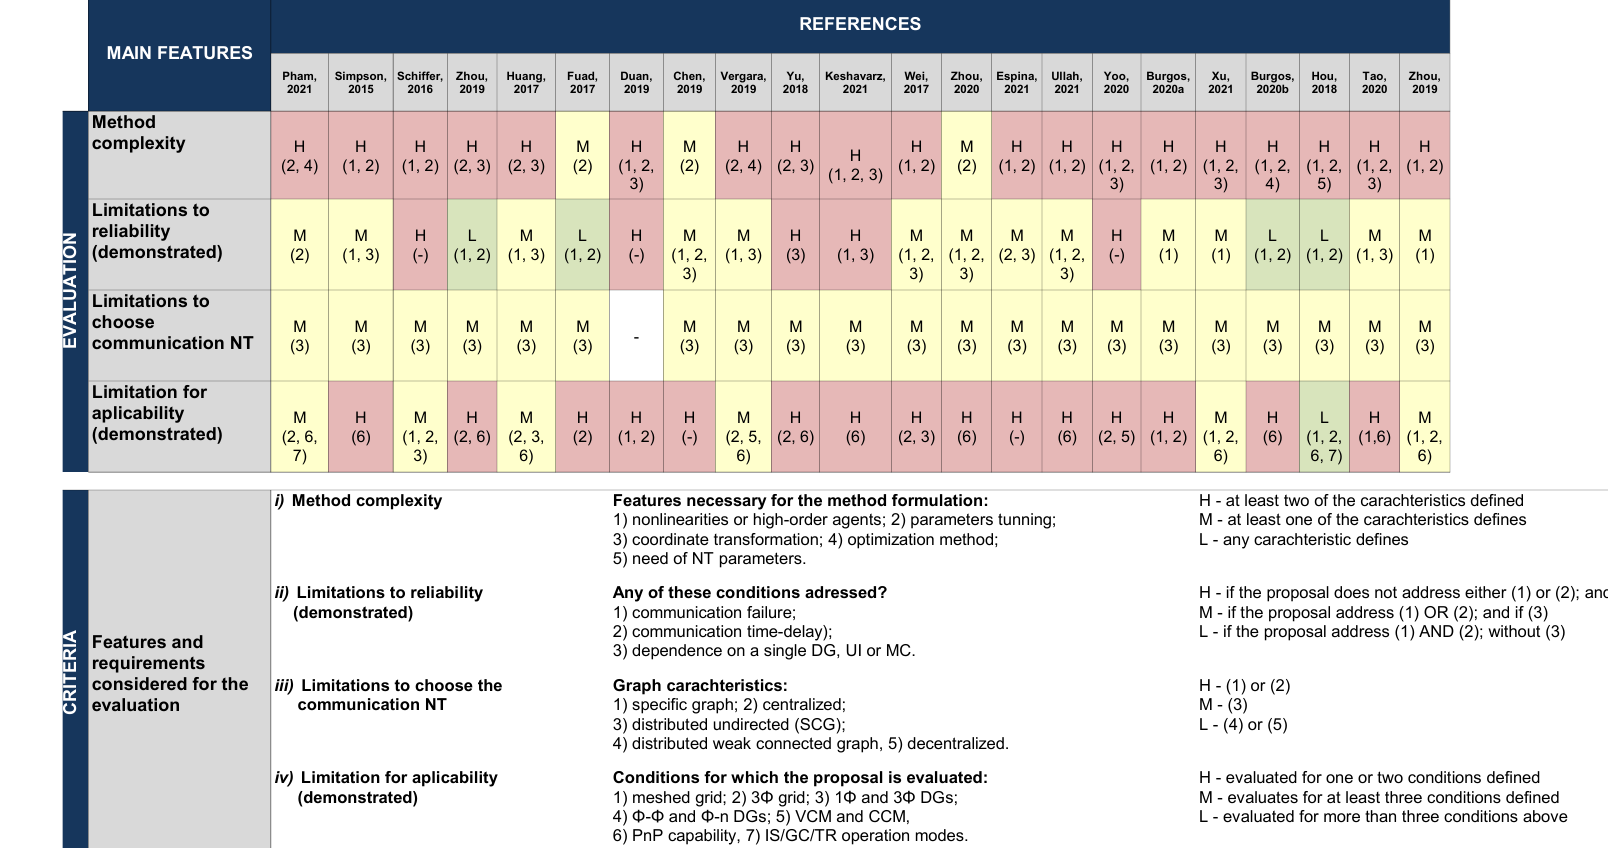
Figure 17. Comparative summary of the literature review—parameters considered: (i) method complexity; (ii) limitations concerning reliability; (iii) limitations to choose communication NT; (iv) method applicability. Legend: Pham, 2021 [111], SimpsonPorco, 2015 [83] Schiffer, 2016 [84], Zhou, 2019 [94], Huang, 2017